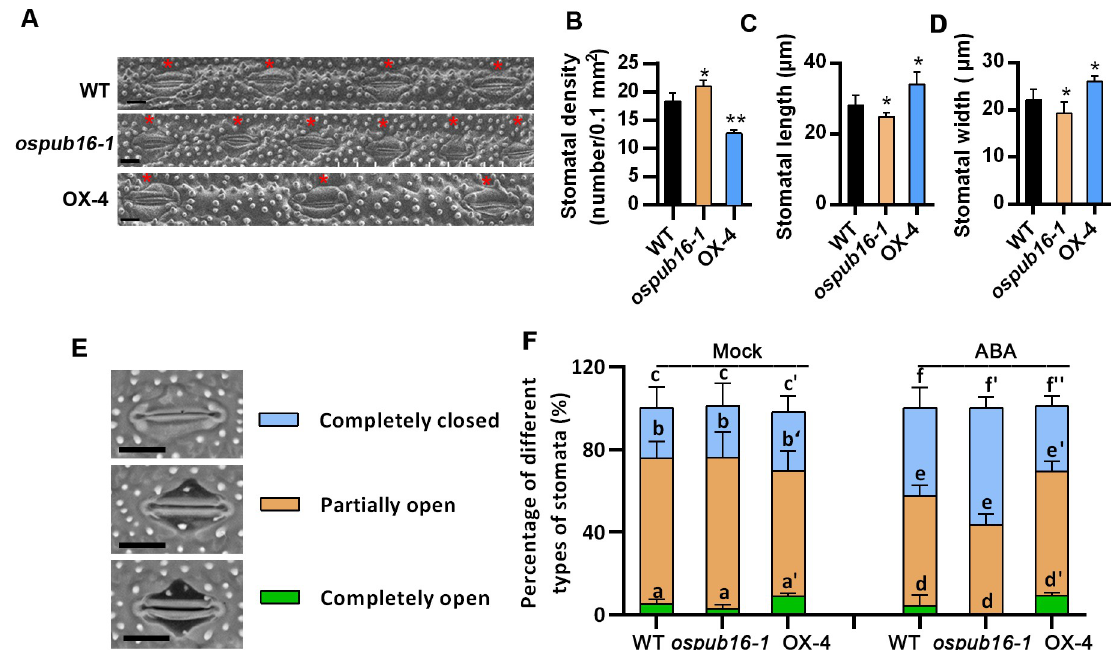
Fig 3. Effects of OsPUB16 on the leaf stomatal development and response to ABA. (A) Stomata of different genotypes on leaves. Scale bars, 50 μ m. The stomata are marked with red asterisks. (B-D) Comparisons of stomatal density, length and width between WT and the transgenic lines, respectively. Data are means ± SD ( n � 200, from 5 independent plants). ( E ) Images showing the completely open, partially open, and completely closed stomata in rice leaves. (F) Percentages of completely open, partially open, and completely closed stomata in different genotypes with or without ABA treatment. Data are means ± SD ( n � 200, from 5 independent plants). In (B-D), the significant difference between transgenic lines and WT was determined by Student’s t test. � p < 0.05, �� p < 0.01 or ��� p < 0.001. In (F), two-way ANOVA followed by Bonferroni’s post-hoc test was performed. Different letters with the same superscript mark indicate significant differences ( p < 0.05) between plants under the same conditions.